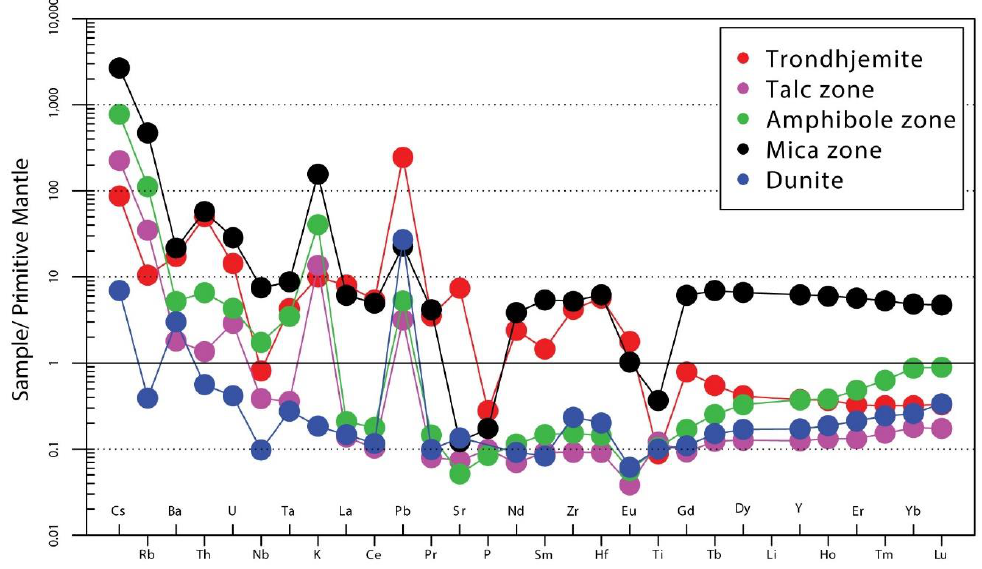
Figure 9. Incompatible trace element diagram normalized to primitive mantle [28]. The dunite, talc and amphibolite samples have the lowest abundances, whereas the mica sample has significantly elevated heavy rare earth element contents and otherwise resembles the granitoid